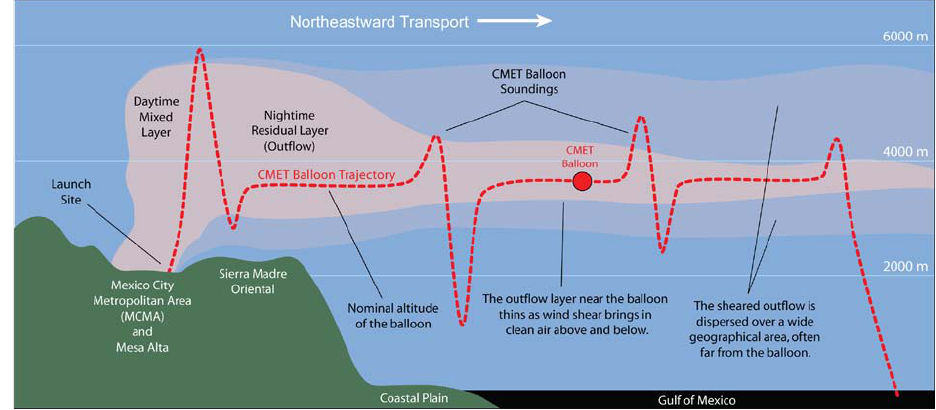
Fig. 1. Summary of the CMET balloon operational strategy during the MILAGRO campaign. Balloons were launched from MCMA into the polluted residual layer in the late afternoon and then commanded to perform repeated soundings as they drifted downwind with the outflow for almost 30h. Generally the balloons were flown in pairs with one performing deep soundings and the other operated more conservatively and in closer proximity to the outflow layer being tracked.